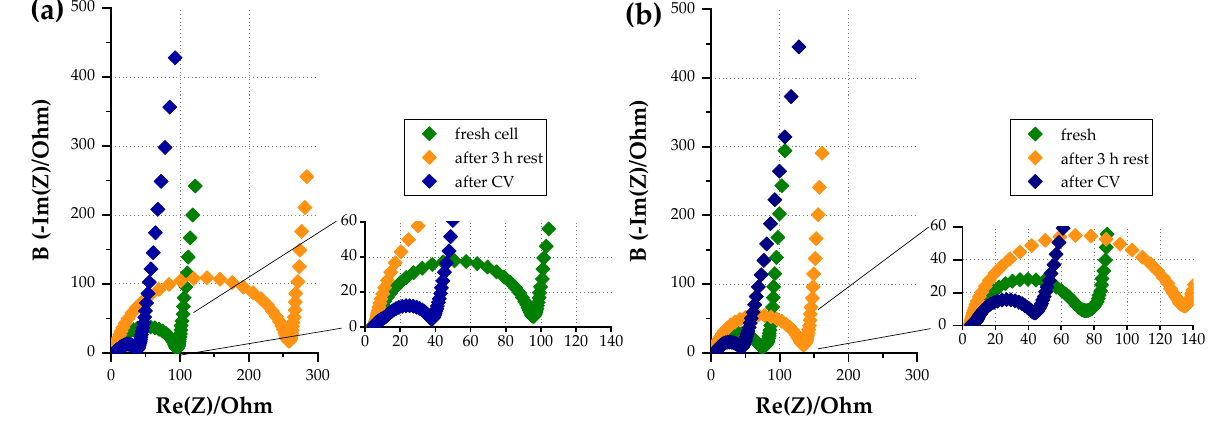
Figure 6. EIS spectra of C-surgical ( a ) and of C-FFP2 ( b ) in 1 M NaClO 4 in PC vs. Na, recorded at three different stages, i.e., just after assembling the cell, after 3 h of rest at OCV and after the cyclic voltammetric analysis shown in Figure 5.